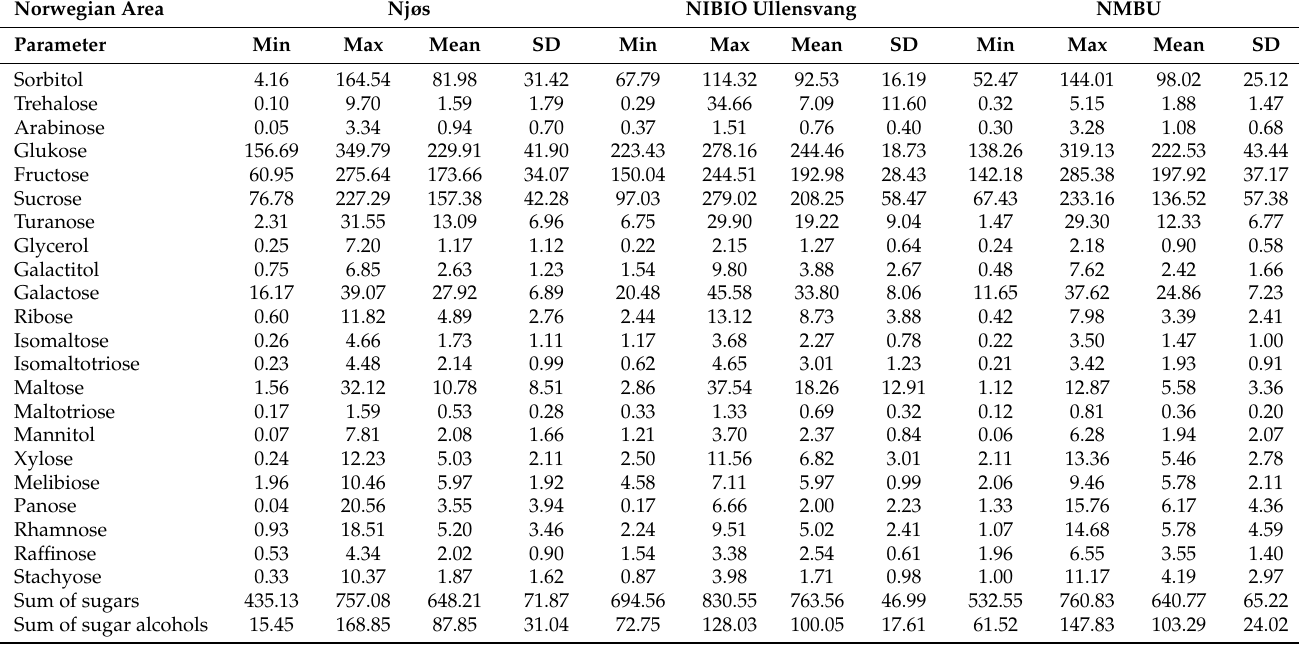
Table 3. Descriptive analysis of sugar content (g/kg dw) in 68 Norwegian plum cultivars from Njøs (42 samples) and NIBIO Ullensvang (8 samples) collected in 2019 and 2021 and from NMBU (18 samples) collected in 2019 and